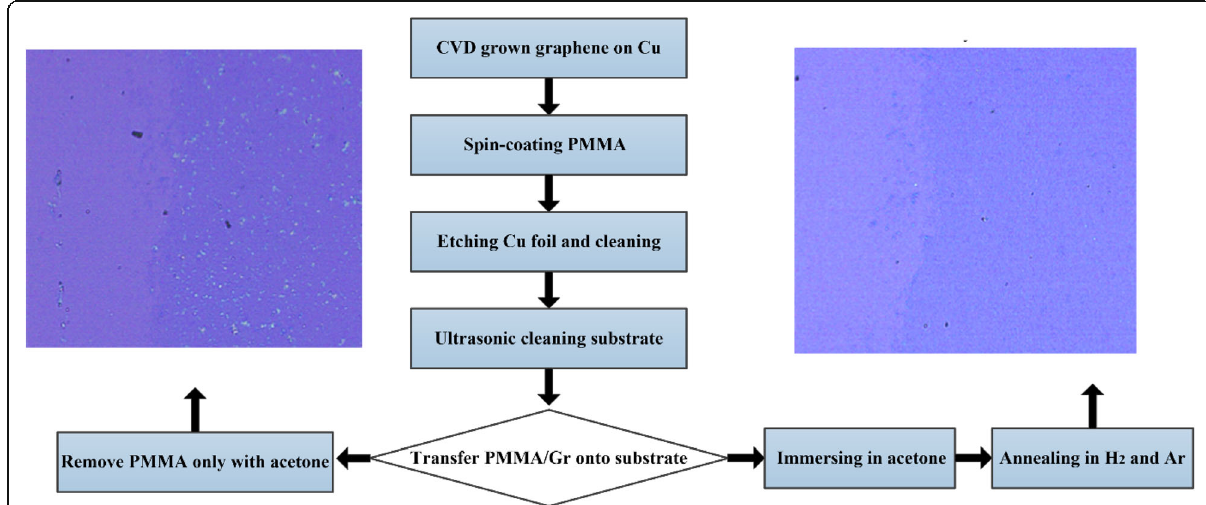
Fig. 1 Processes for chemical transfer of graphene w/o annealing in reducing atmosphere. The insets are the optical photographs of graphene transferred on SiO 2 /Si substrate with (right) or without (left) annealing, respectively